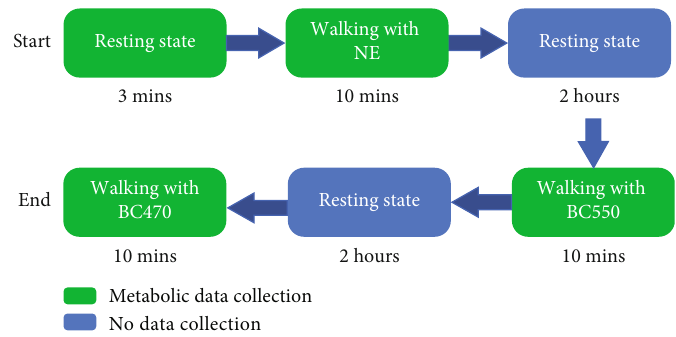
Figure 17: The process of metabolic cost